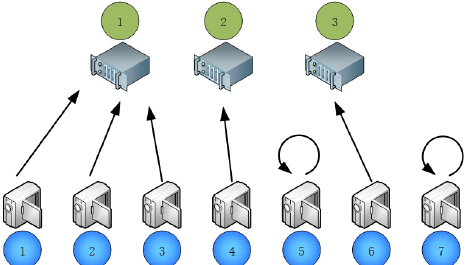
Figure 5. Agent joint-action of 10,000 epoch training. In the above experimental settings, an optimal situation for two devices would be to select an edge computing node for computation offloading at the same time. In this scenario, three devices simultaneously select an edge node for offloading, which will cause channel congestion and increase the request delay. Nodes 2 and 3 are selected by only one device in computation offloading, which will lead to a waste of resources, while one device is chosen for local computation. The desired optimal effect was obviously not achieved in this action situation.